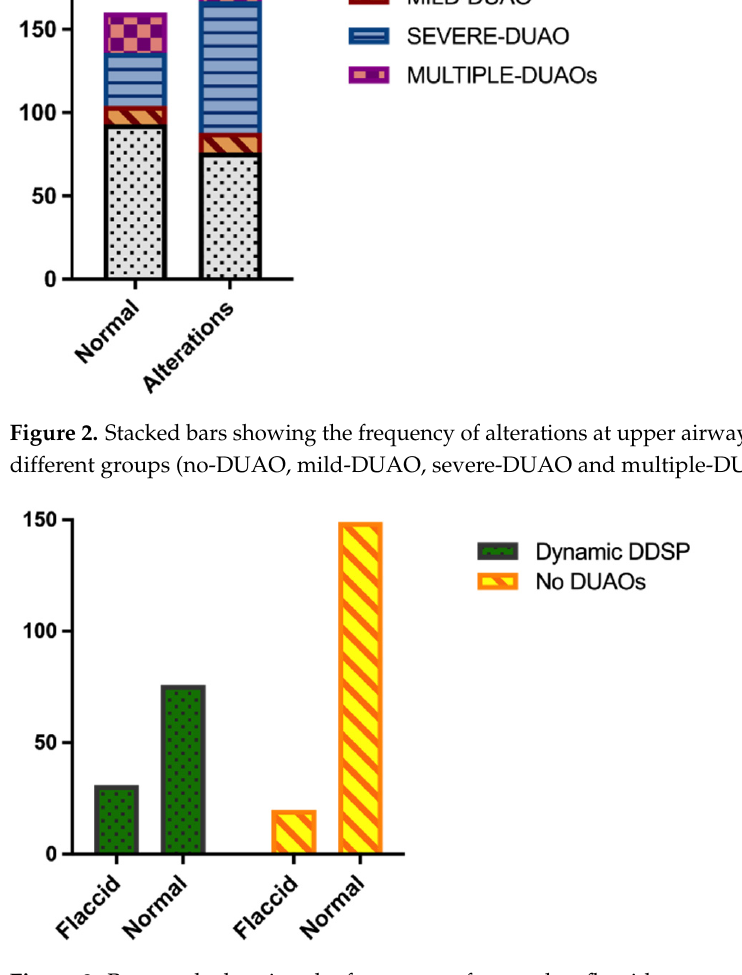
Figure 3. Bar graph showing the frequency of normal or flaccid appearance of epiglottis at upper airway resting endoscopy in the horses with no DUAOs and with DDSP diagnosed at HSTE.